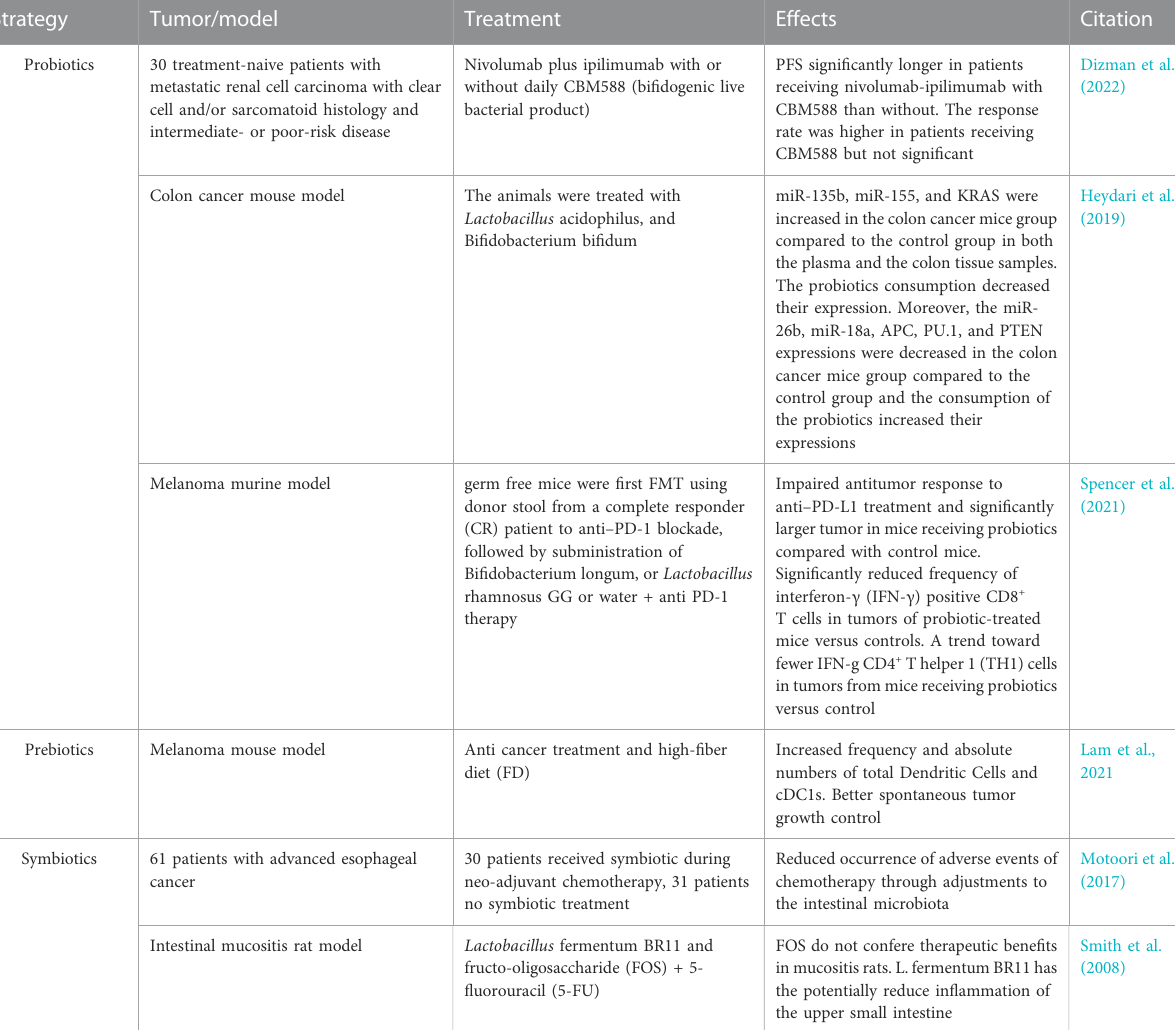
TABLE 1 ( Continued ) Summary table of all the microbiota manipulation methods reported in the